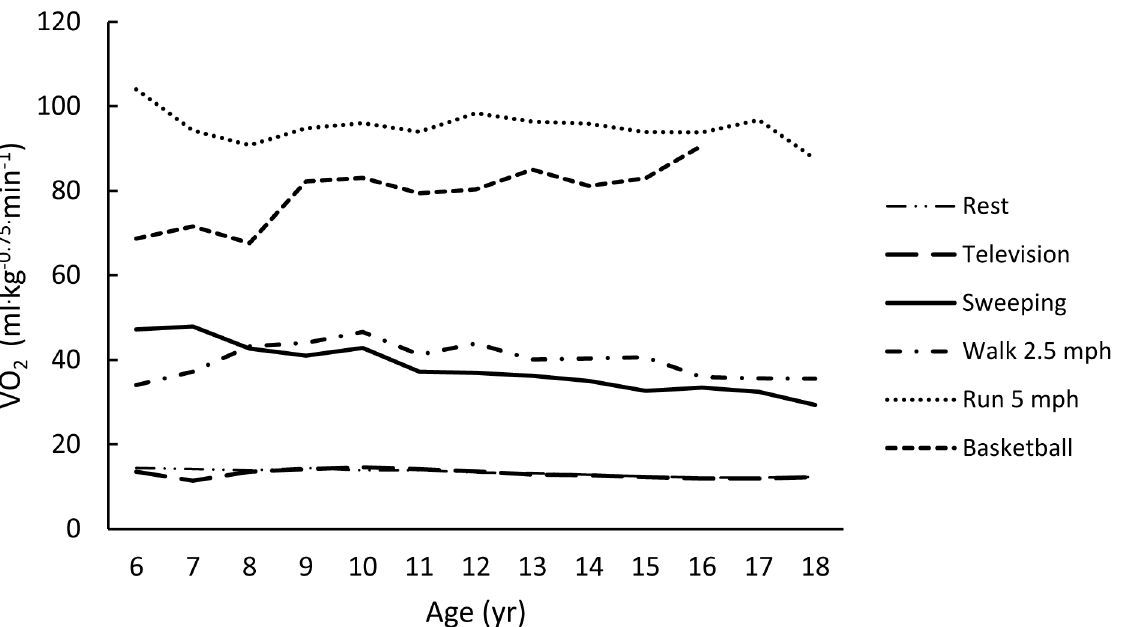
Fig 4. The relationships between age and VO 2ALLOM (ml . kg -0.75. min -1 ) for six activities representing various intensities of physical